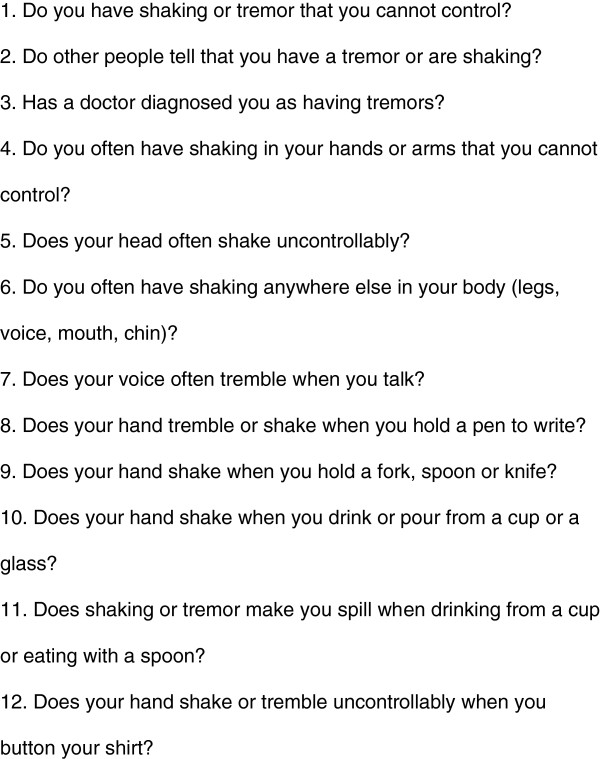
 List of questions in12-item ET specific questionnaireused in stage 2(case ascertainment).